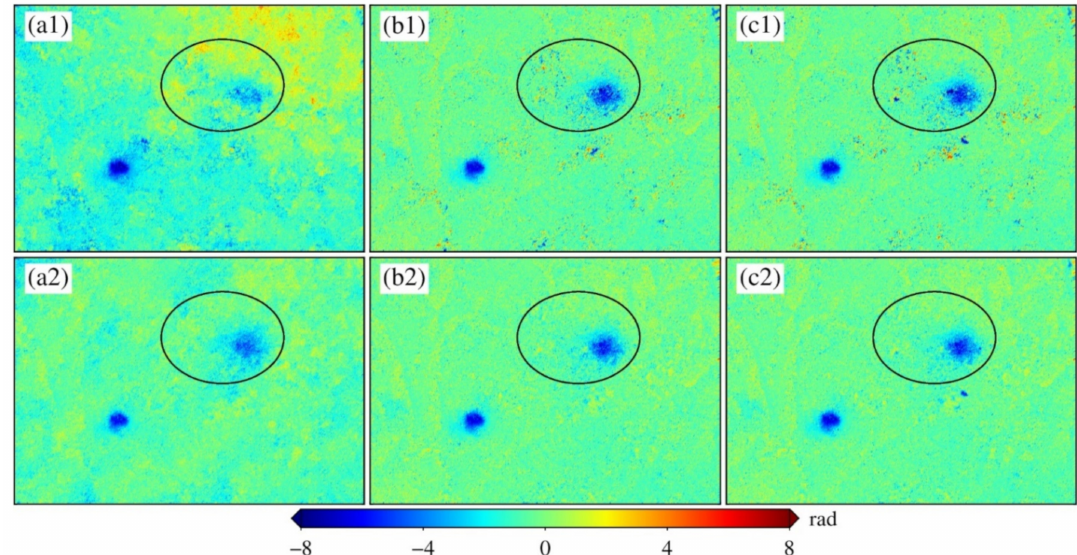
Figure 8. Phase unwrapped results of different methods: ( a1 ) PU results of no hierarchical WLS method; ( a2 ) WLS method for first-level points and HNCA method for second-level points; ( b1 ) PU results of no hierarchical mcf method; ( b2 ) mcf method for first-level points and HNCA method for second-level points; ( c1 ) PU results of no hierarchical snaphu method; ( c2 ) snaphu method for first-level points and HNCA method for second-level points. The black ellipse indicates an area that is heavily polluted by noise and has low